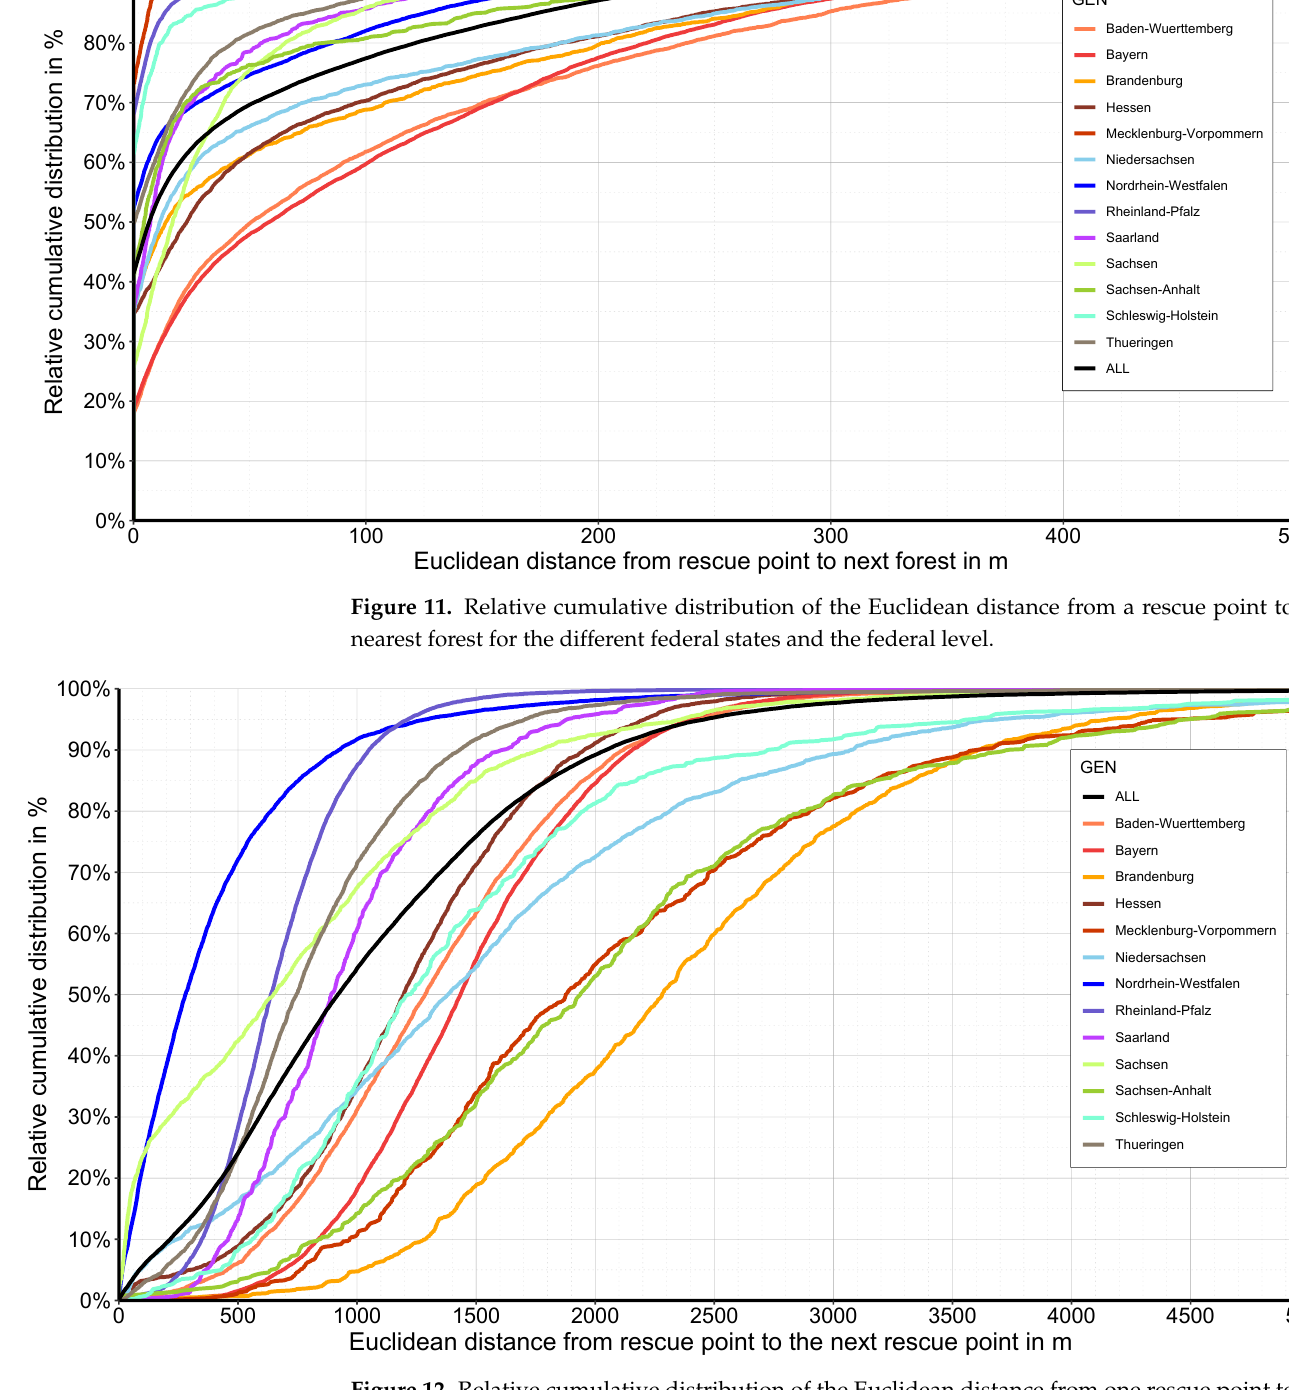
Figure 12. Relative cumulative distribution of the Euclidean distance from one rescue point to the next rescue point for the different federal states and the federal